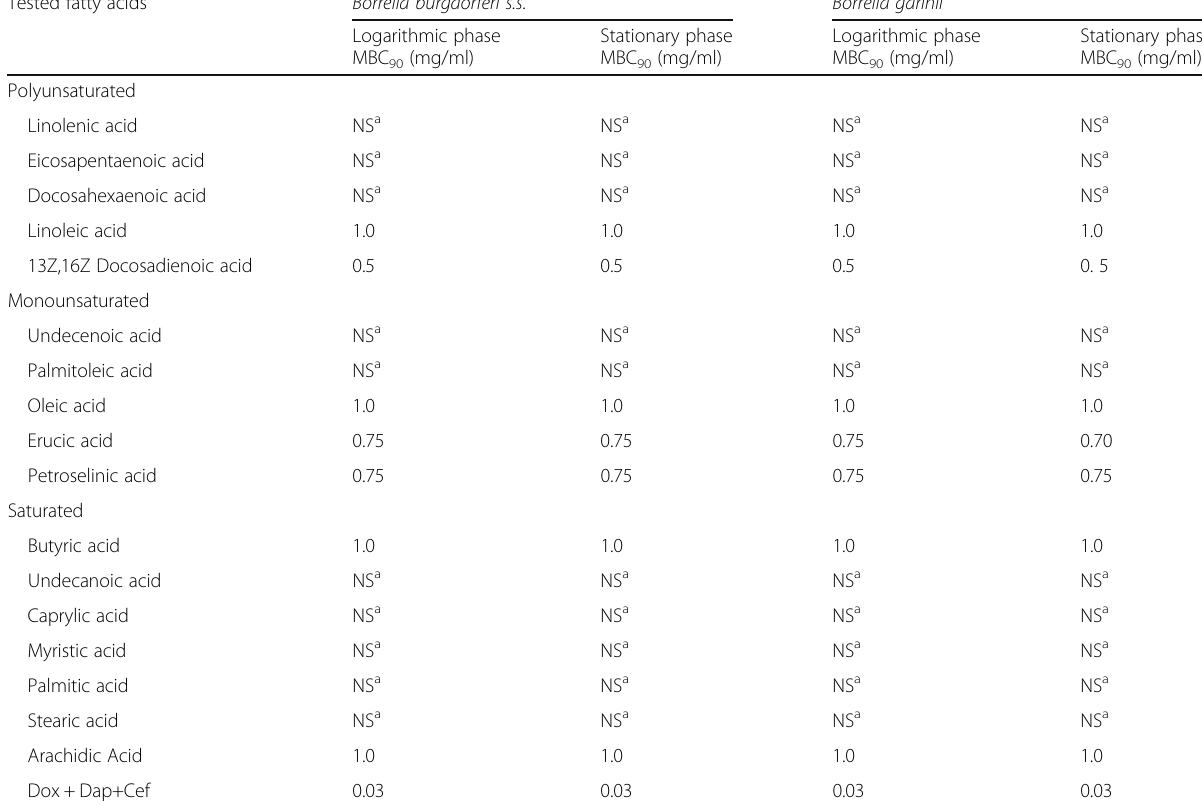
Table 2 Bactericidal efficacy of fatty acids against logarithmic and stationary phases of Borrelia burgdorferii s.s. and Borrelia garinii Tested fatty